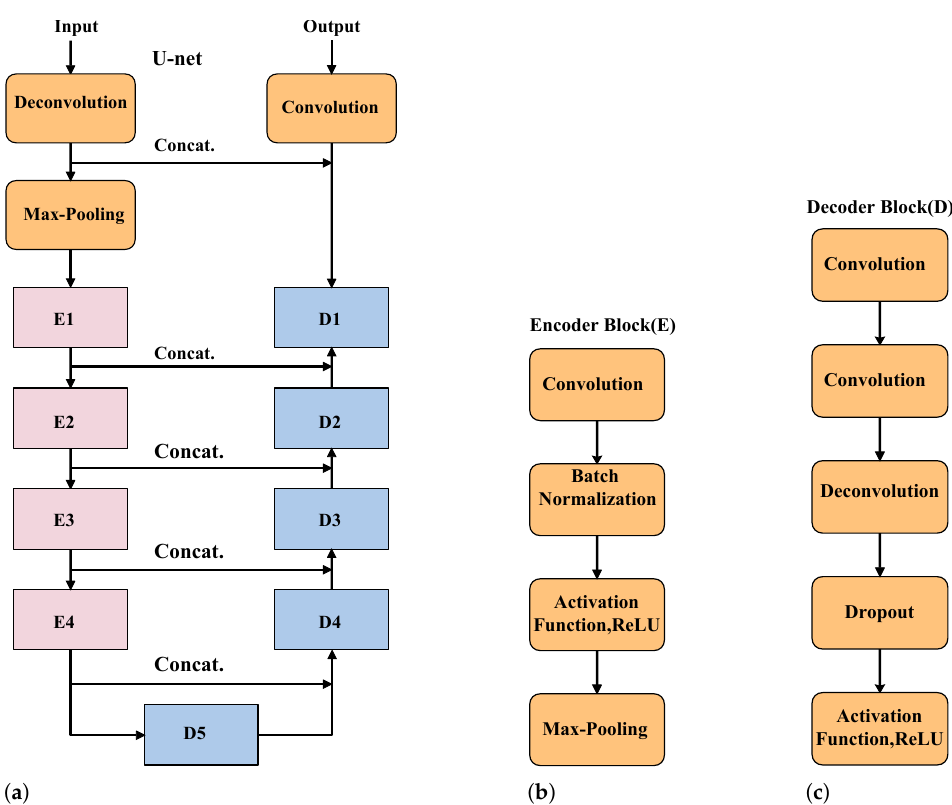
Figure 5. Denoising network architecture. ( a ) Framework of the denoising network. ( b ) Framework of the encoder block. ( c ) Framework of the decoder